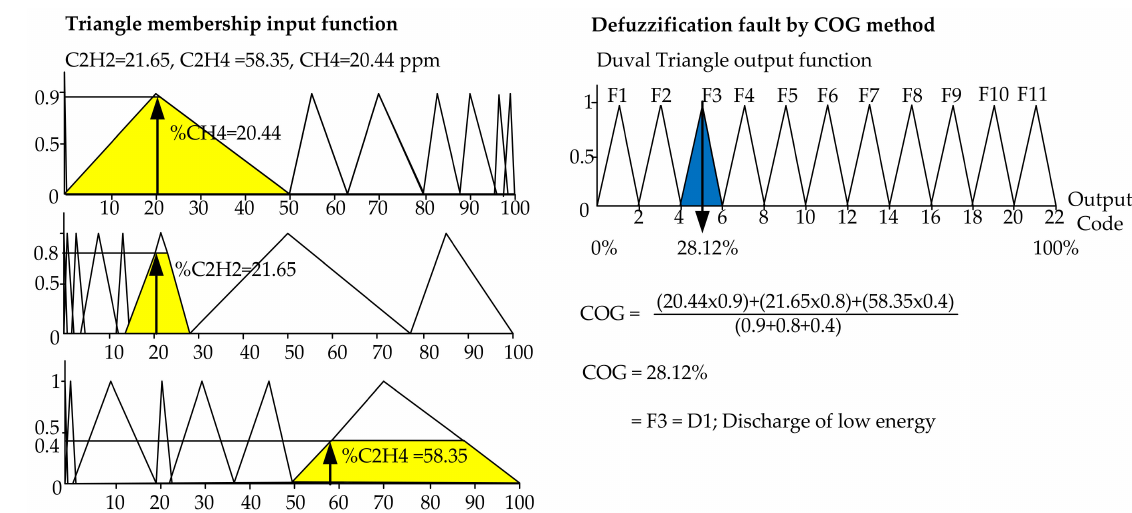
Figure 8. Triangular membership function fuzzification and defuzzification for the Duval triangle method.